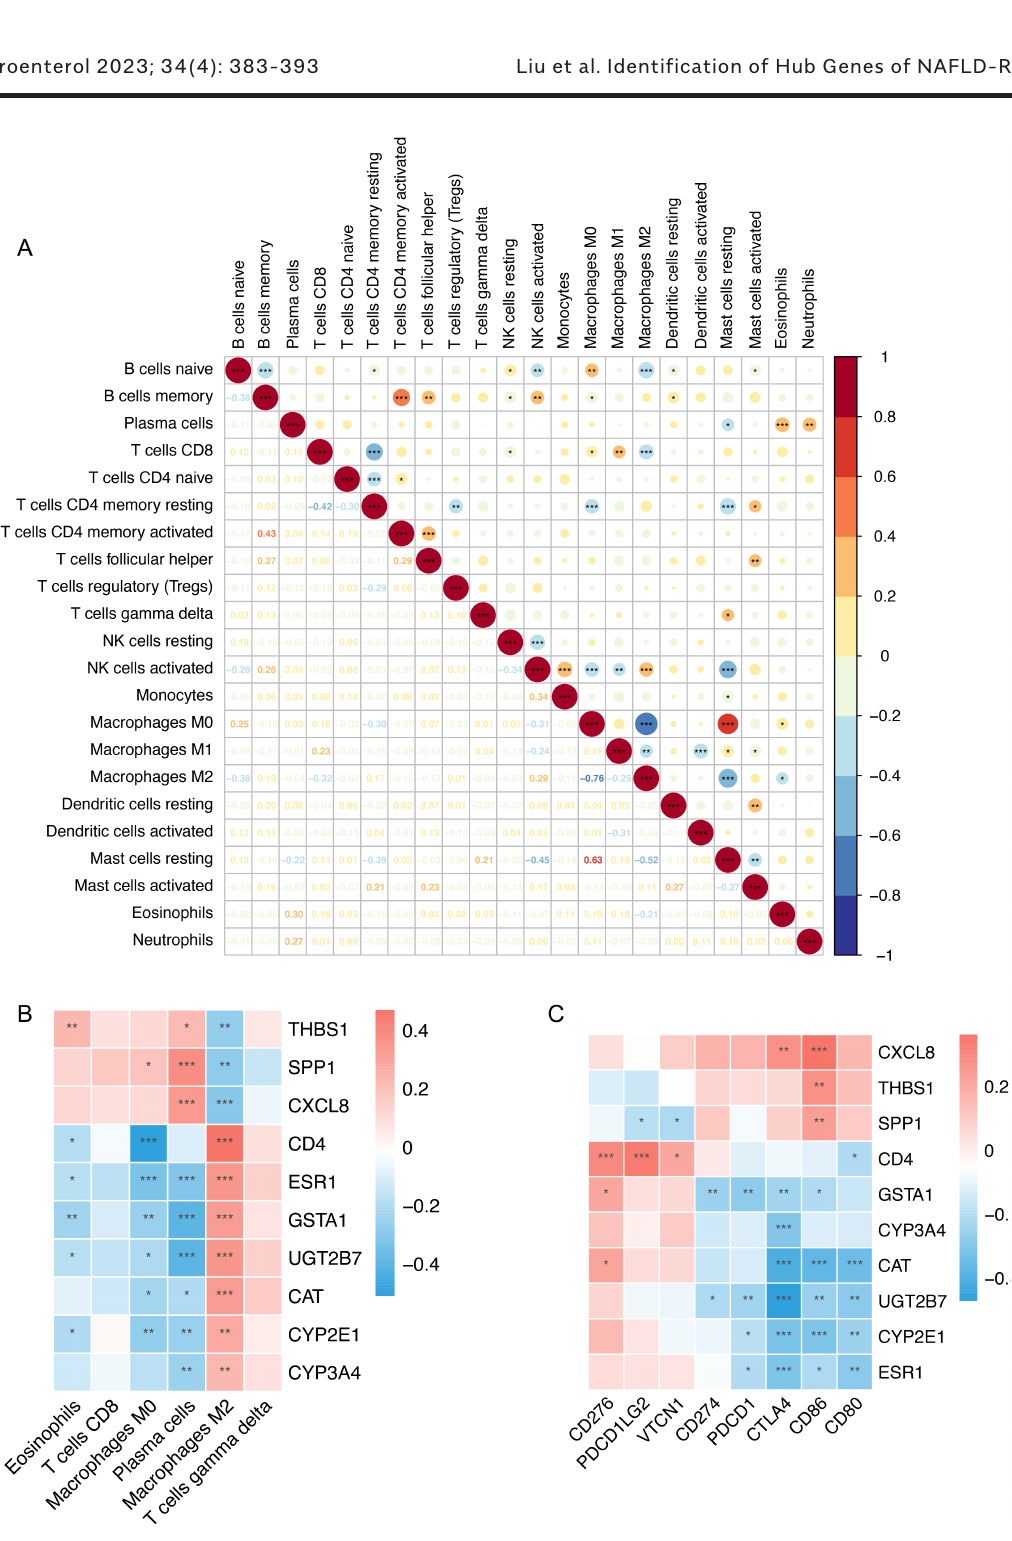
Figure 4. Correlation of hub genes and immune cells. (A) The correlation of 22 immune cells. Red represents positive correlation and blue represents negative correlation. Lower panel was Pearson’s correlation coefficient. In the upper panel, the size of the circle is positively correlated with the correlation coefficient. (B) The correlation between each hub gene and changed immune cells. Red, positive; blue, negative. (C) Correlation between the 10 hub genes and 8 immune checkpoint